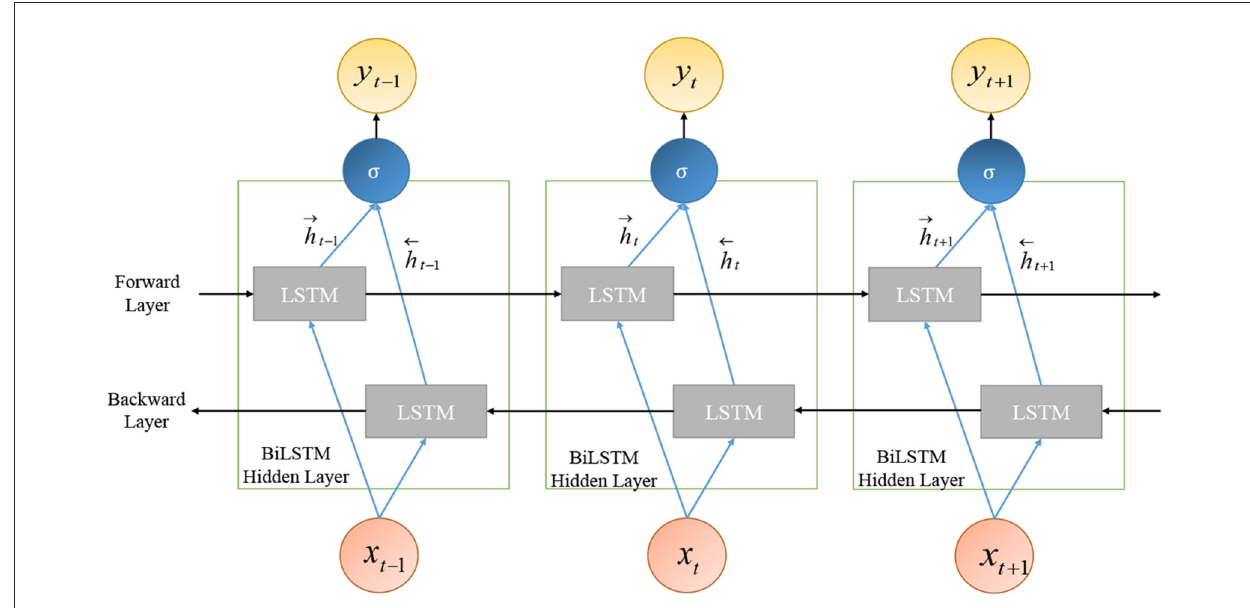
FIGURE8 Bi-directional long short-term memory (Bi-LSTM).